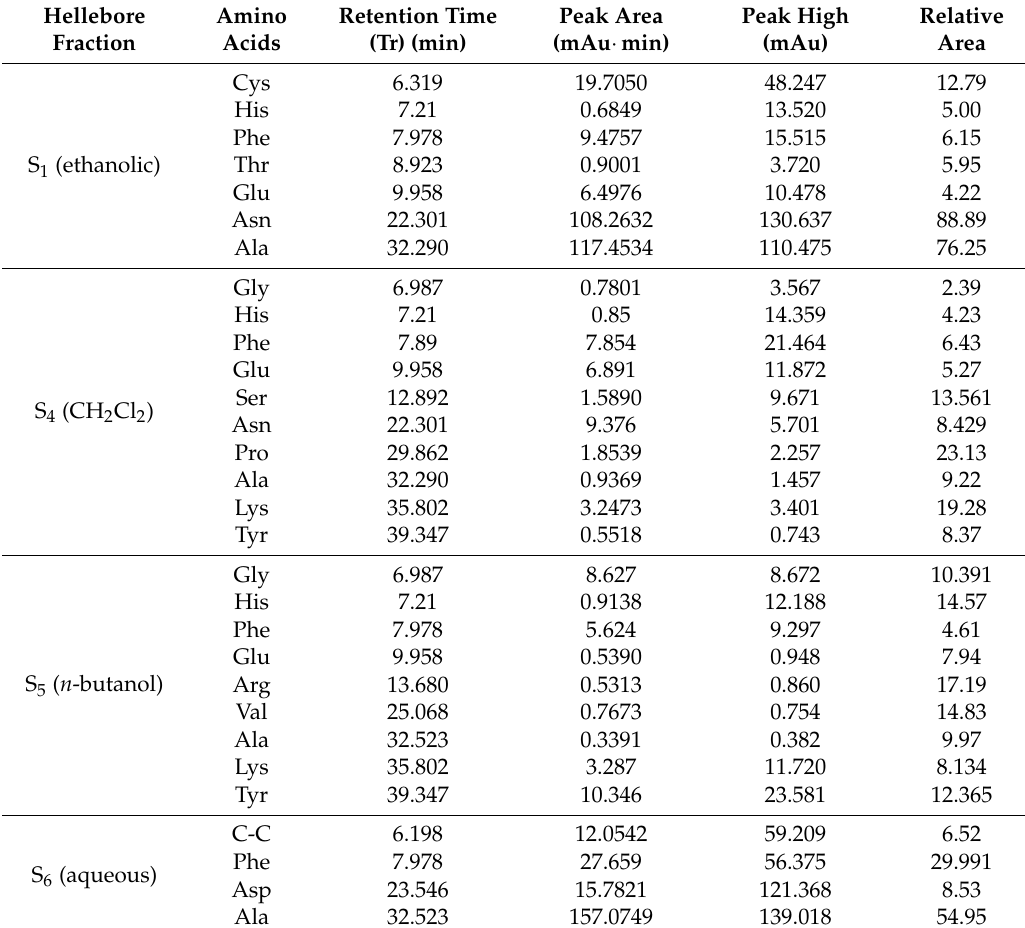
Table 1. RP-HPLC identification of Helleborus purpurascens amino